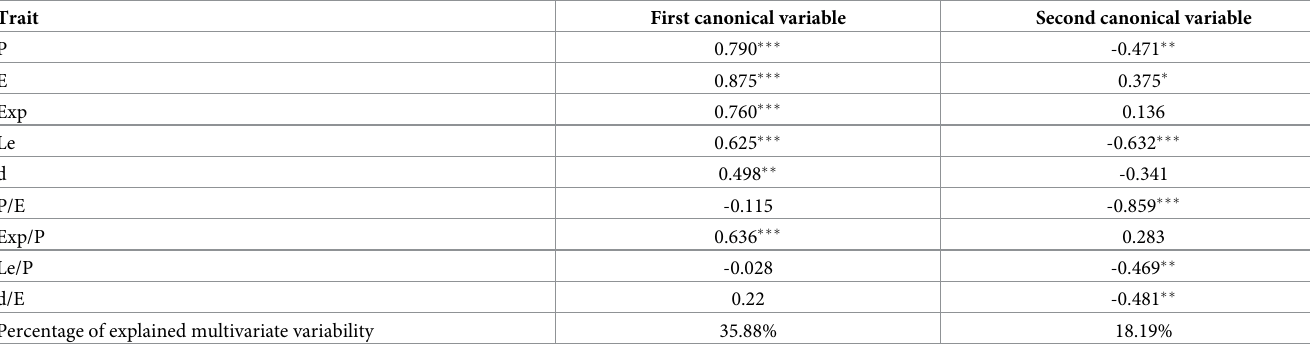
Table 6. Correlation coefficients between first two canonical variables and original